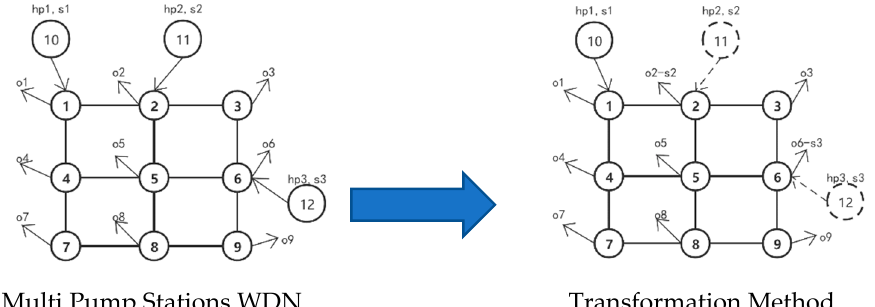
Figure 3. Schematic diagram of transformation method for a multi pump stations water distribution network.